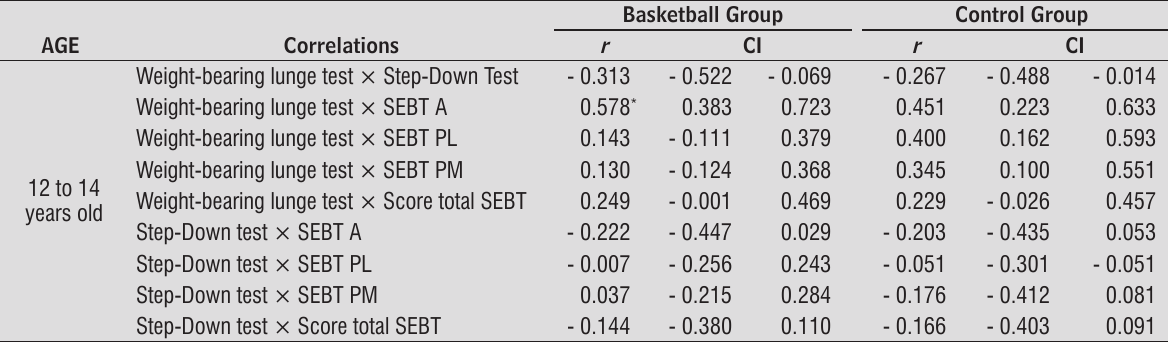
Table 3 - Pearson’s correlation coefficient for basketball and control groups according to age Basketball Group Control